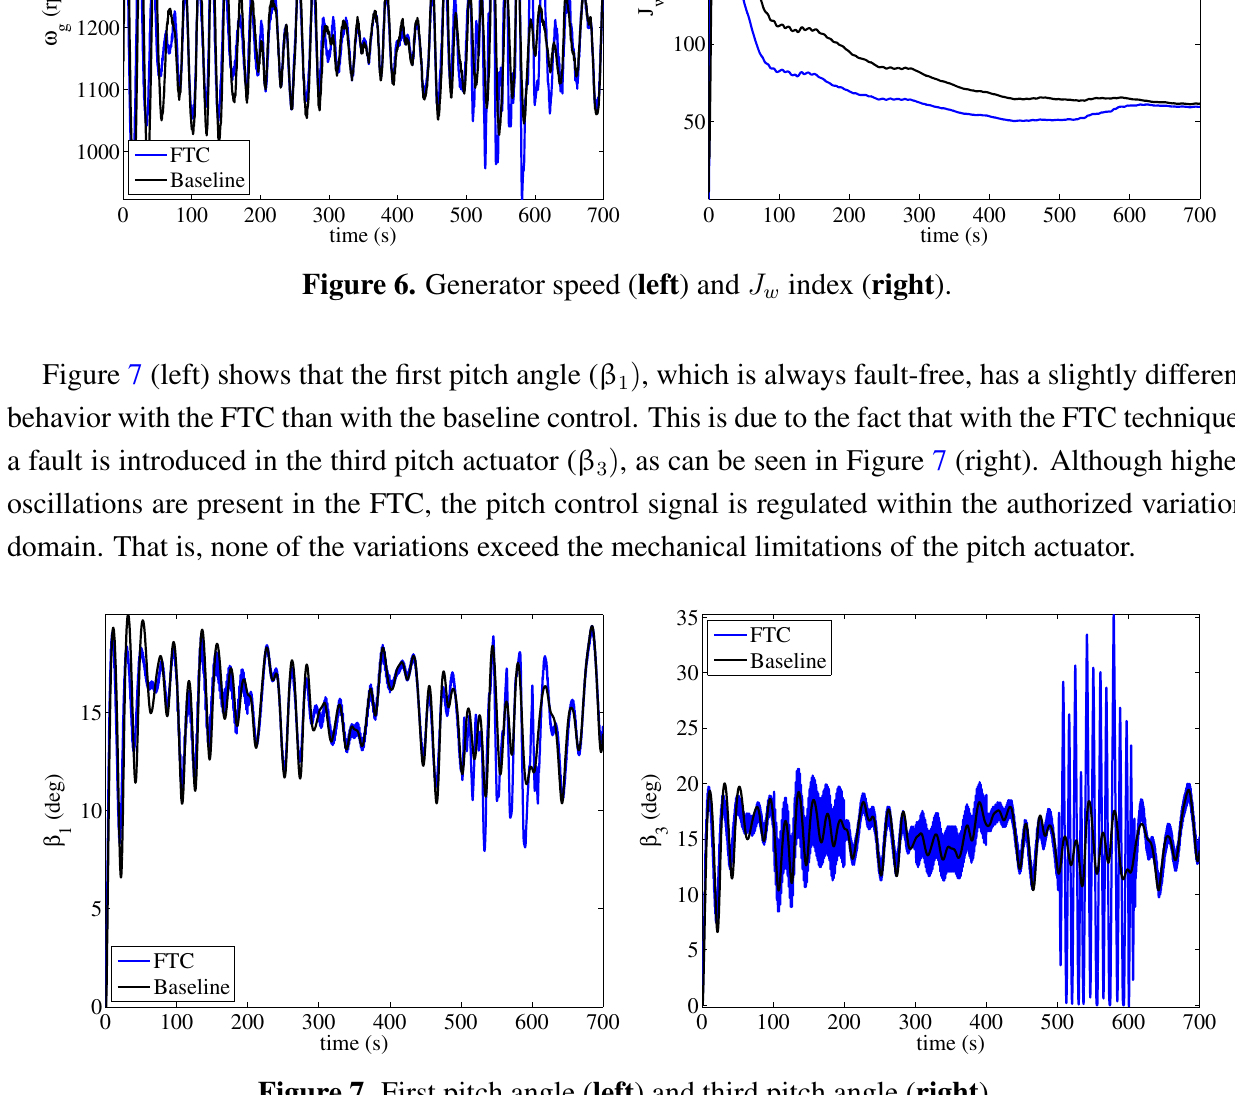
Figure 7. First pitch angle ( left ) and third pitch angle ( right